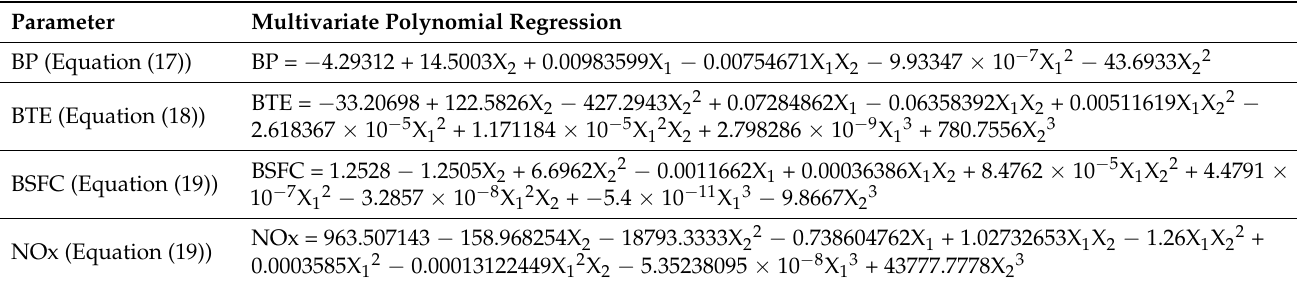
Table 4. Multivariate polynomial regression (MPR) equations.